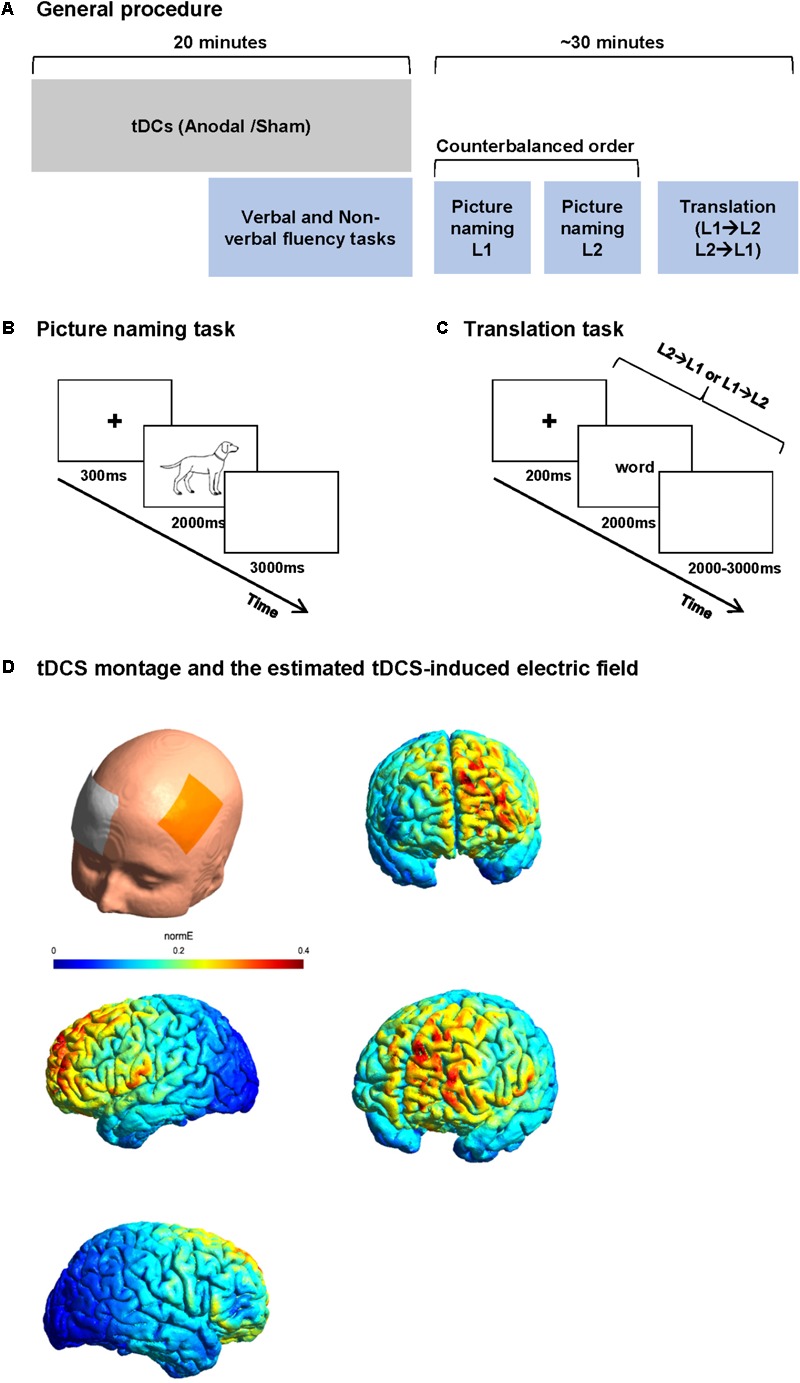
Study procedure and tasks. (A) Study procedure: each participant participated in two sessions 1 week apart. In each session, participants received 20 min of anodal or sham tDCS. The participants performed verbal and non-verbal fluency task before the end of stimulation. After the stimulation, the participants performed two blocks of picture naming (in L1 and L2 in a counterbalanced order between subjects) and finally a word translation task. (B) Picture naming paradigm. Participants were asked to name the images presented on the screen as fast as possible. (C) Word translation task. Participants were randomly presented words in L1 or L2 and were asked to translate it to L2 or L1 as fast as possible. (D) An estimate of the electric field induced by our tDCS montage in the anodal condition.